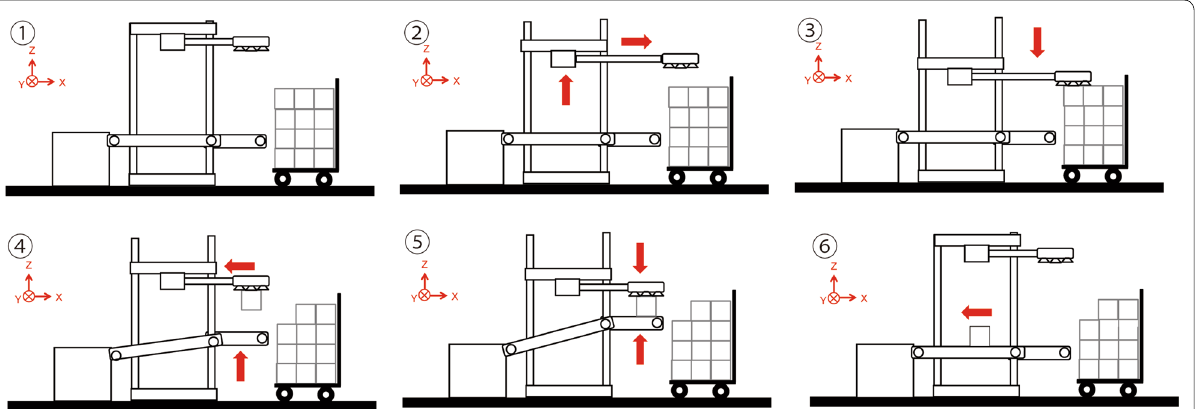
Fig. 32 Operating procedure of unloading operations by the linear motion-type depalletizing robot